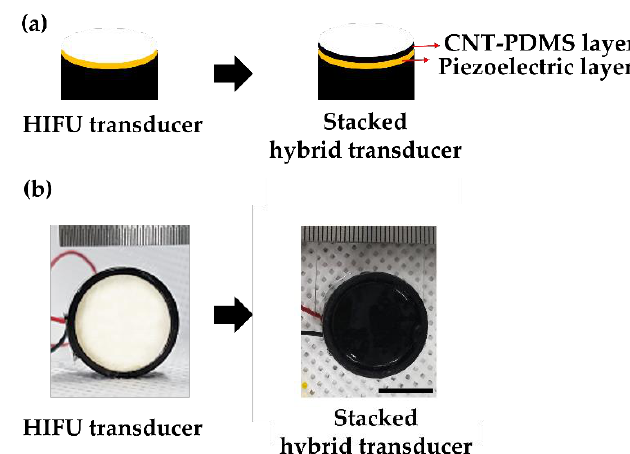
Figure 2. ( a ) A cross-sectional schematic of the stacked hybrid transducer. The yellow layer indicates the piezoelectric transmitter for HIFU. The top black layer presents the CNT–PDMS film which was directly coated upon the piezoelectric transmitter. ( b ) Photographs ( top view) of the piezoelectric transmitter ( left ) and the fabricated hybrid transmitter with the CNT–PDMS layer (right). (Scale bar = 10 mm).